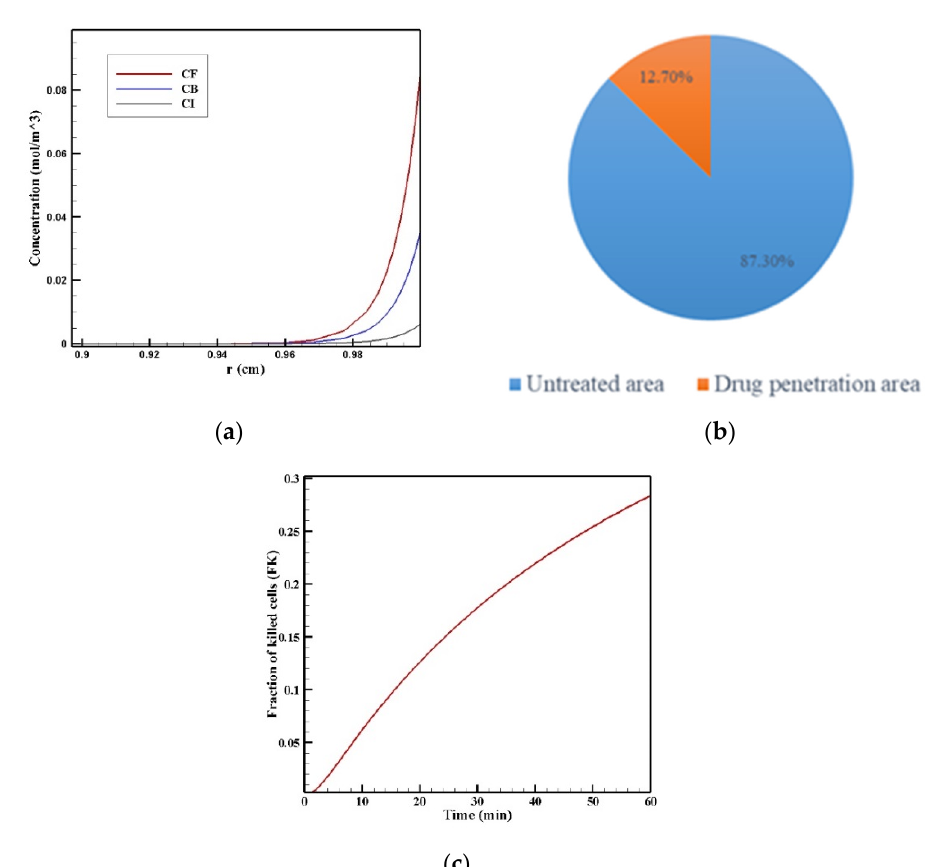
Figure 8. ( a ) Mean concentration profiles of the free drug (C F ), bound drug (C B ), and internalized drug (C I ) along the tumor radius after 60 min of treatment; ( b ) pie chart of the drug penetration area and untreated area of the tumor; ( c ) fraction of killed cells in the drug penetration area ( FK PA ) in terms of time over 60 min of chemotherapy by IP injection.